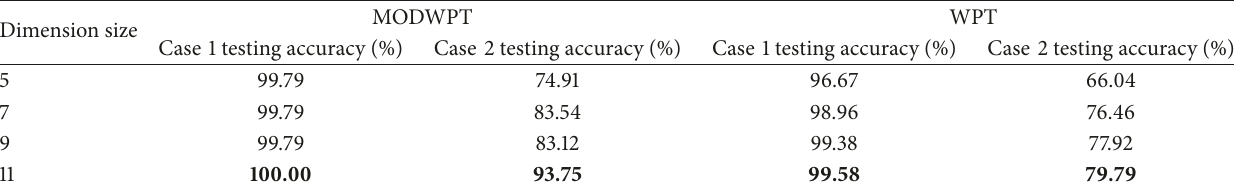
Table 6: Bearing fault diagnosis results obtained by OFS-LDA-SVM.